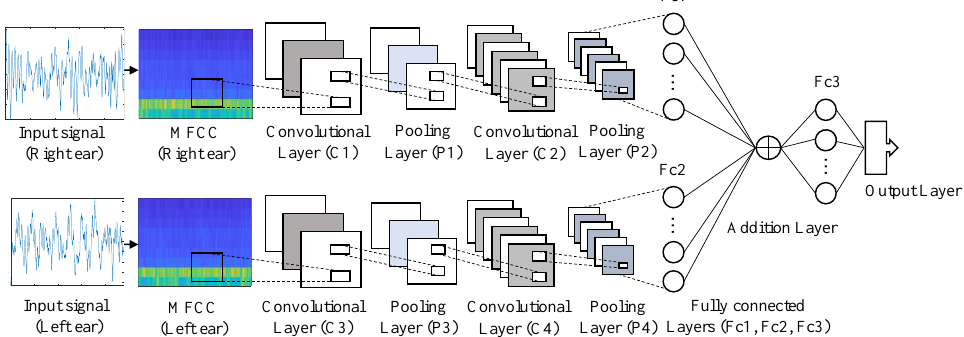
Figure 11. Binaural MFCC-CNN sound quality model.